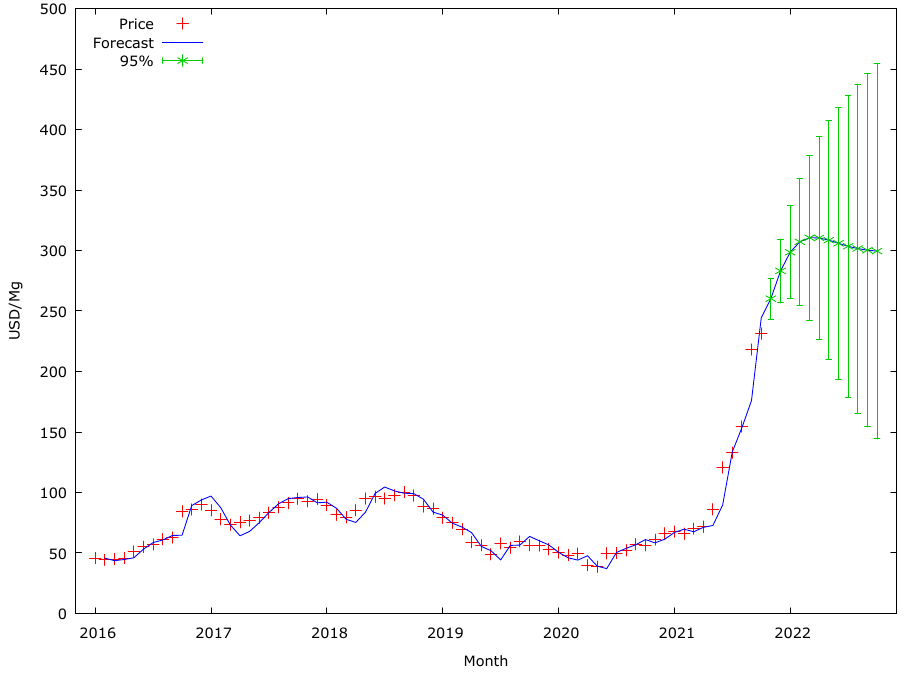
Figure 6. Hard coal price forecast until 10 January 2022.